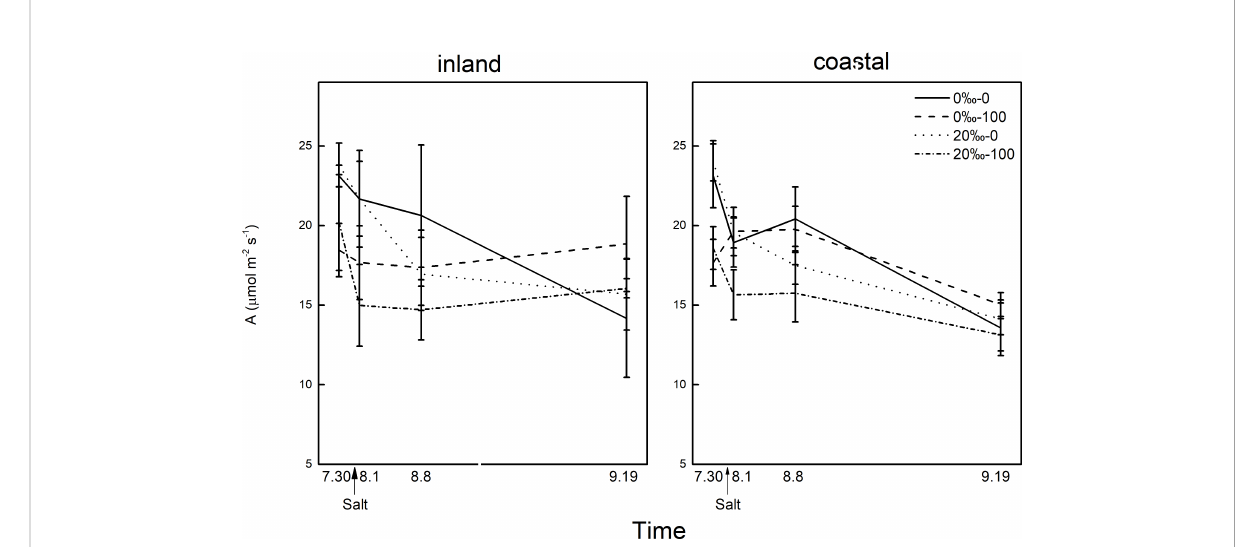
FIGURE 4 The difference in photosynthetic rate (A) of Phragmites australis populations grown with salt (0 ‰ , 20 ‰ ) and DNA demethylation treatment (0, 100 m mol) at different